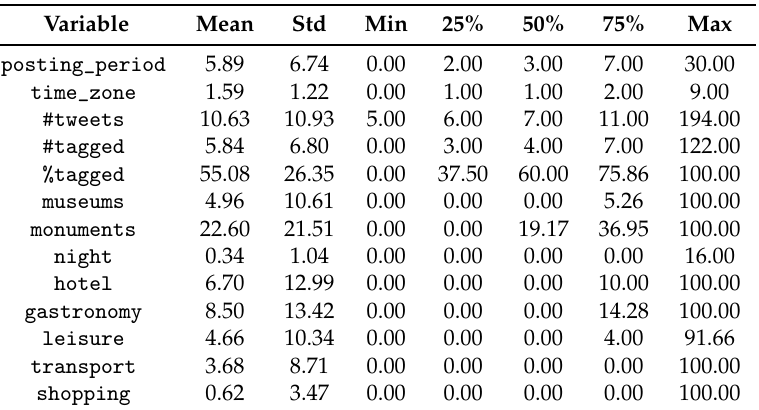
Table 6. Berlin dataset statistics.